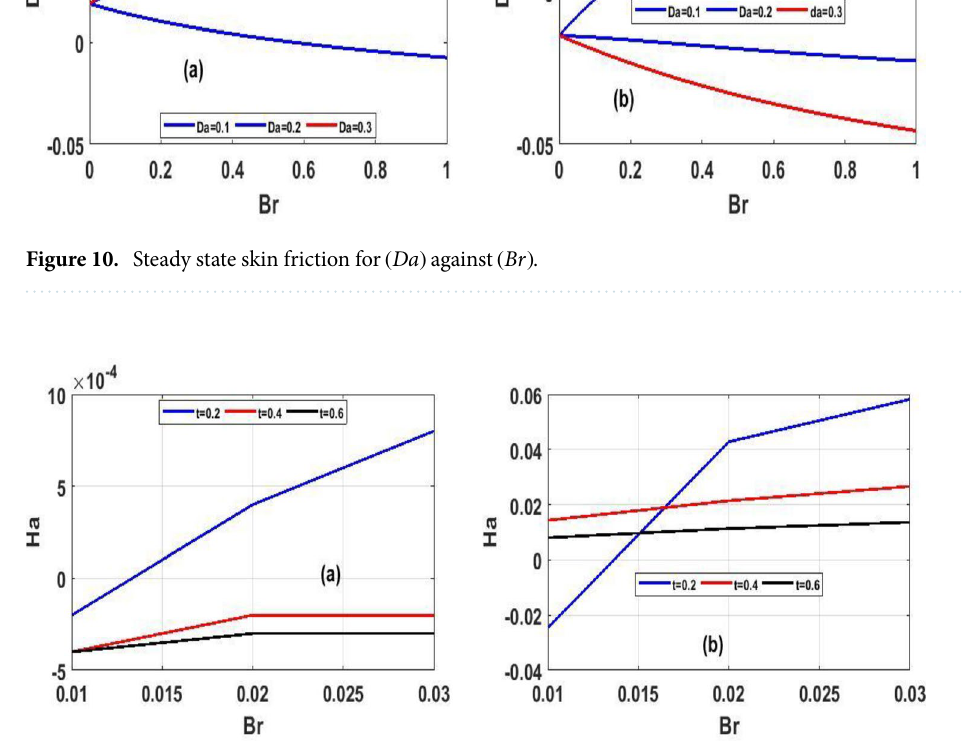
Figure 11. Unsteady state skin friction for ( Ha ) in proportion to ( t ) .